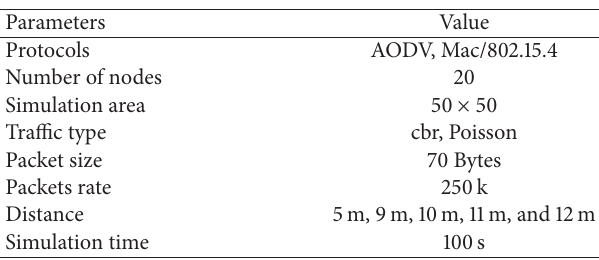
Figure 6: End-to-end throughput with 𝐾 = 20 nodes. Table 2: Simulation